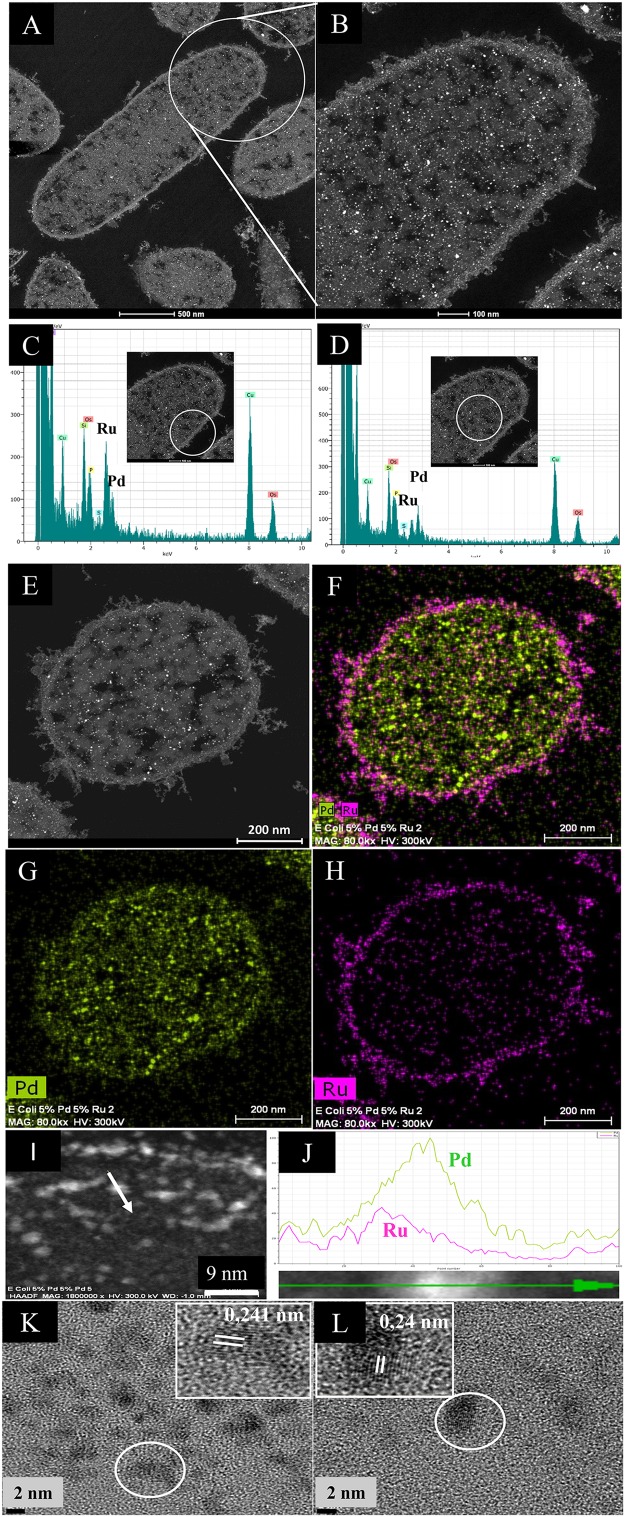
HAADF/STEM micrographs of cell sections (A) and magnified view. Bars are 500 nm (B) of 5 wt% Pd/5 wt% Ru NPs. Bars are 100 nm. EDX is shown of the cell surface (C) and intracellular (D) regions. A single cell (E) is shown mapped for areas of Pd (G) and Ru (H) localization and co-mapped to show distribution of the two elements (F). Bars are 200 nm. An enlarged image of panel (F) is shown in Supplementary Figure S4 to show overall lack of co-mapping of the two elements on visual inspection but also that intracellular Ru is very evident. An example NP in the cell surface region (I, arrowed; scale bar is 9 nm) was analyzed by transect (J) to show association between Pd (green) and Ru (magenta), especially evident on one side of the NP as a skewed distribution. The green arrow (bottom) shows distance across the transect (as a percentage 0–100%) and the Y-axis is counts (arbitrary). (K,L) HRTEM images of single NPs from membrane-bound (K) and cytoplasmic (L) NPs showing lattice fringes. Scale bar is 7 nm.